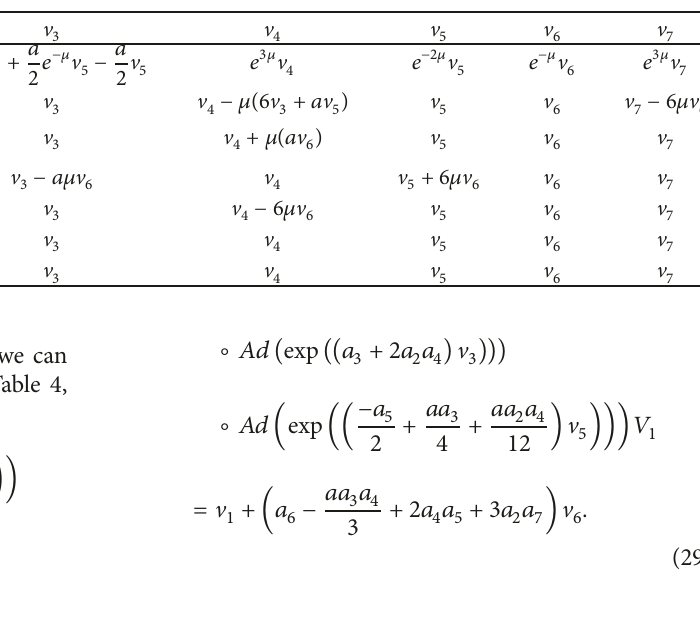
Table 4: Adjoint representation of approximate symmetry of